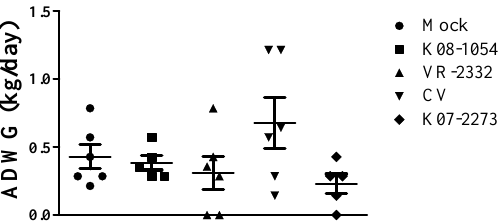
Figure 3. Effect of virus replication on pig growth. The average daily weight gain (ADWG) was calculated from six pigs in each group at 25 dpv. The bars represent the means, and the error bars represent the standard errors of the mean (SEM).